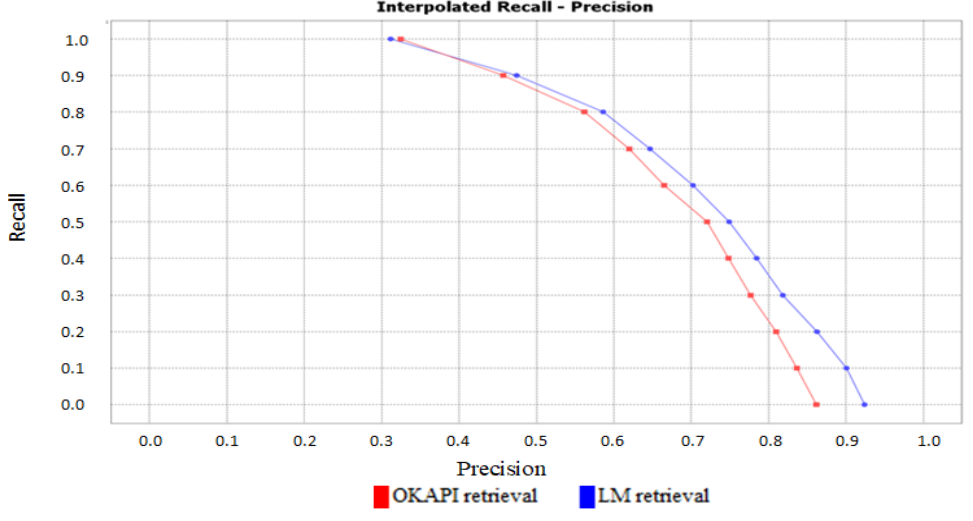
Figure 6. The performance of LM and BM25.